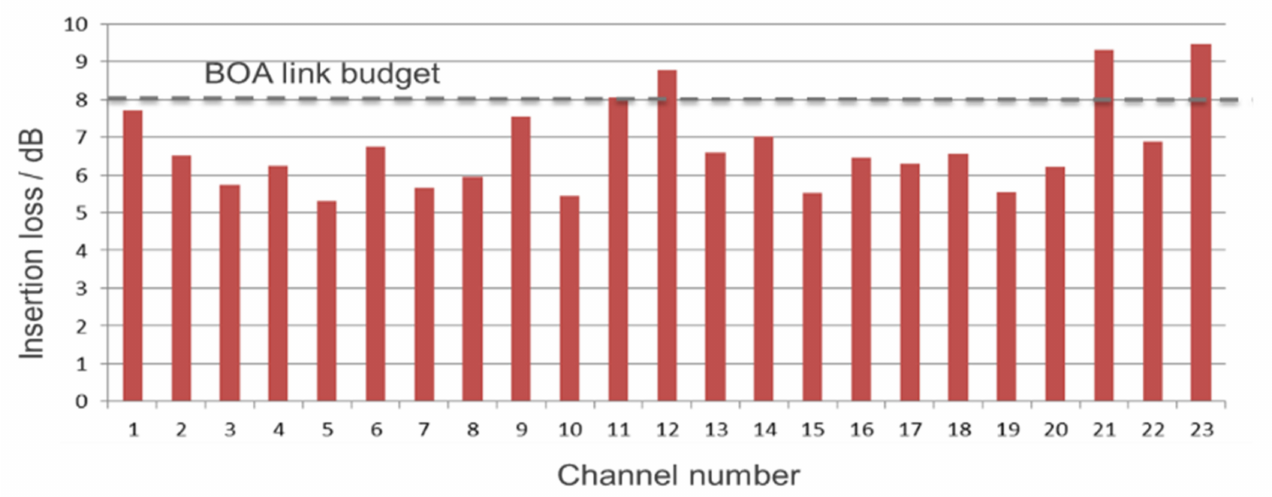
Figure 6. Insertion loss measurements of complete end-to-end link from BOA1 to